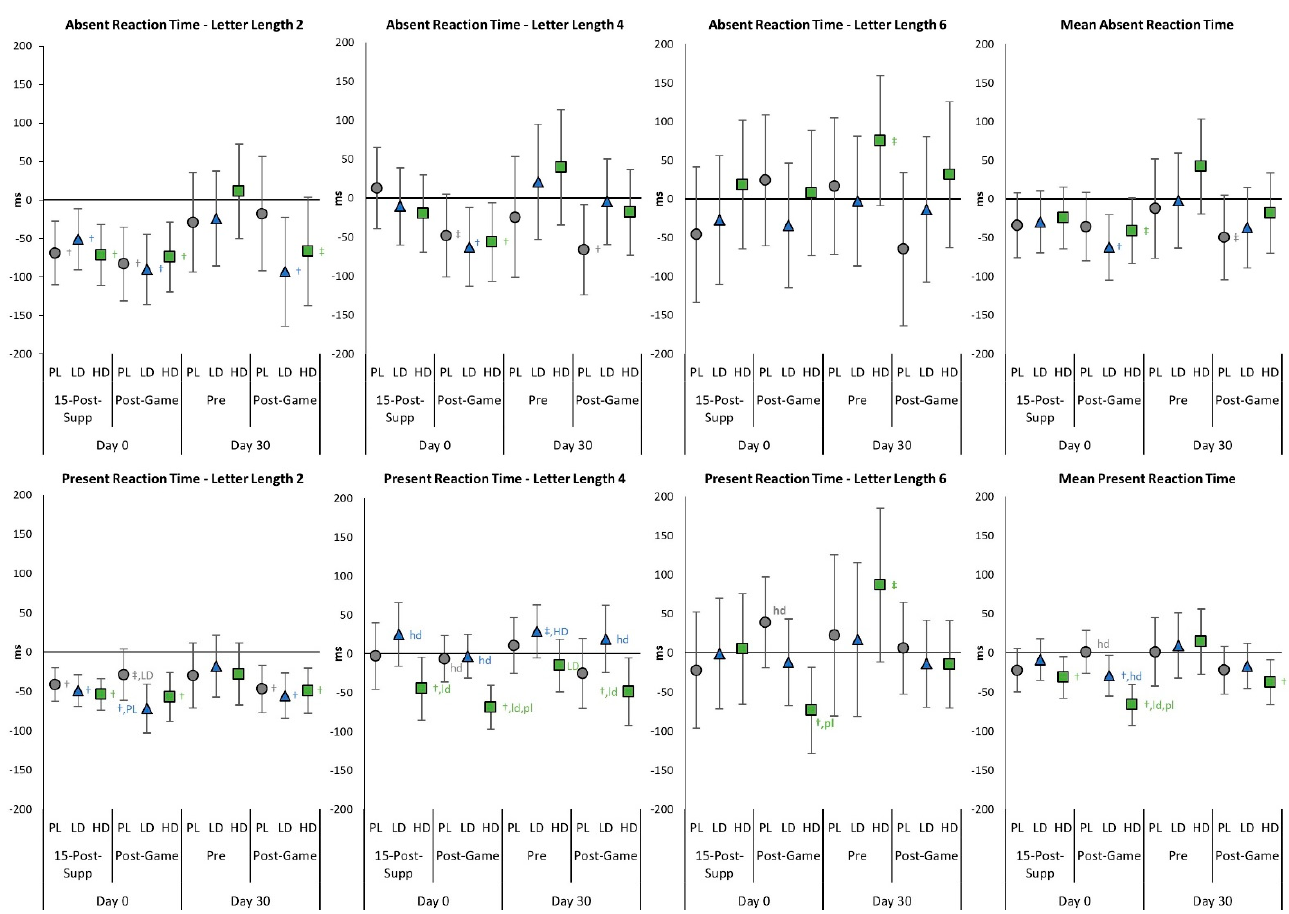
Figure 6. Sternberg Task Test mean Absent and Present Reaction Time changes with 95% confidence intervals from Day 0, pre-game (Pre) values for the placebo (PL), low-dose (LD), and high-dose (HD) groups. † represents p < 0.05 from Pre values while ‡ represents p > 0.05 to p < 0.10 e ff ect. 15-min-Post-Supp represents data obtained 15 min after supplementation, and Post-Game represents data obtained after competitively playing video games for 60 min. Group di ff erences ( p < 0.05) are shown as di ff erences from placebo (pl), low-dose (ld), and high-dose (hd) groups, while statistical tendencies ( p > 0.05 to p < 0.10) are shown in large cases (PL, LD, HD).